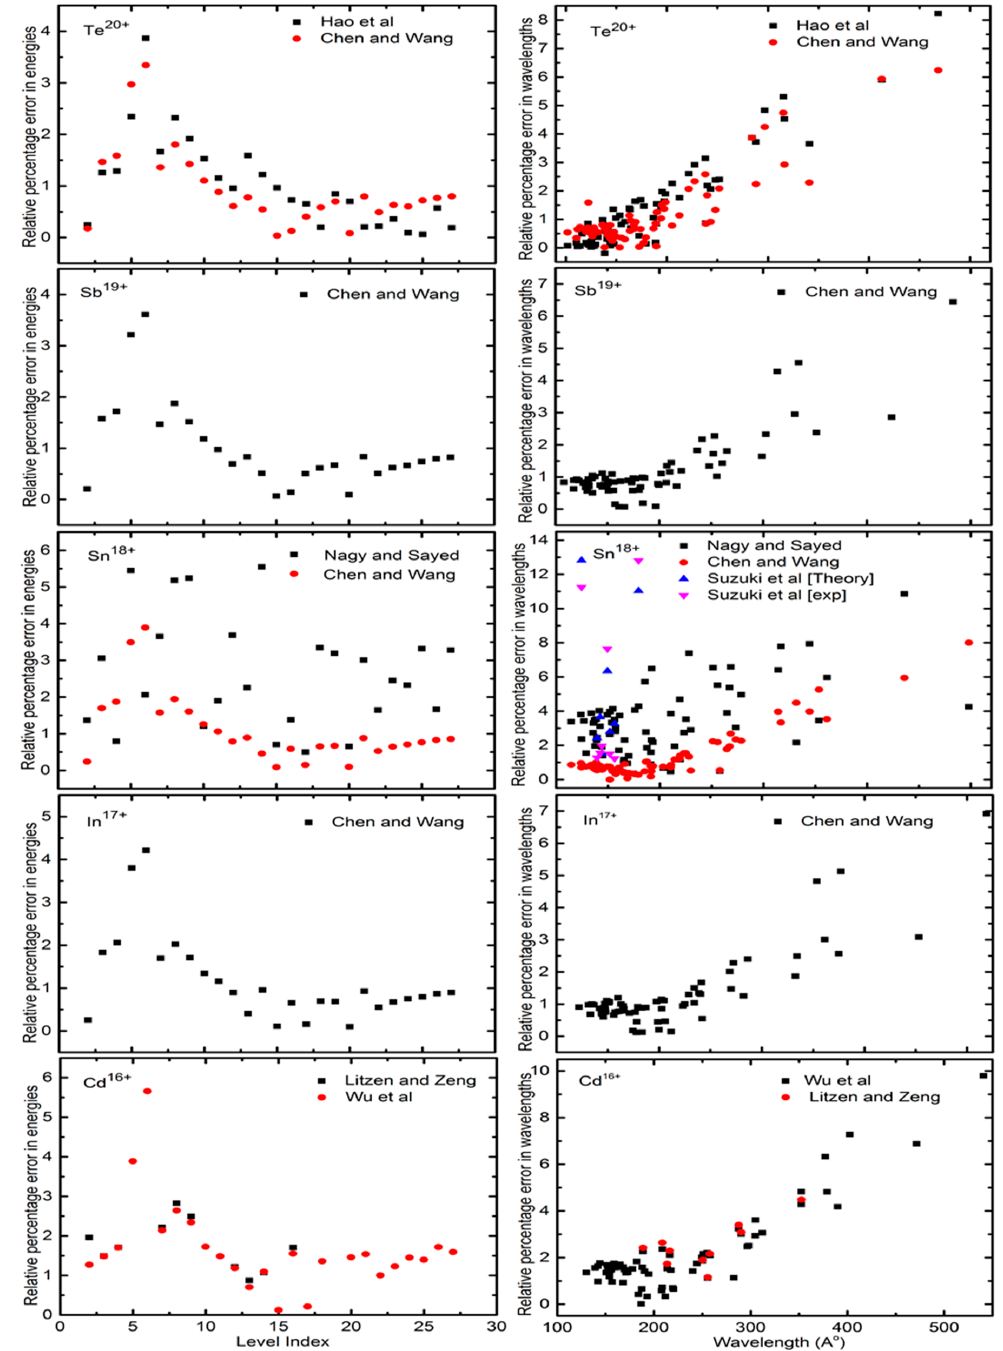
Figure 1. Percentage errors relative to the present energies (left panel) and wavelengths (right panel). Other results are from Sujuki et al. [4], Litzén and Zeng [9], Hao et al. [10], Nagy and Sayed [11], Chen and Wang [12] and Wu et al. [13].